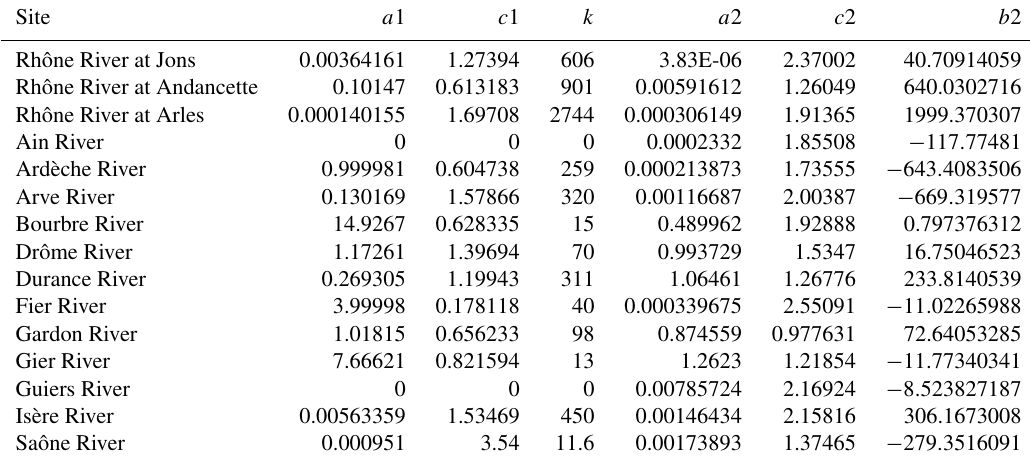
Table 5. Parameters of the discharge-SSC relations (Eq. 1) for all the OSR monitoring stations. Site